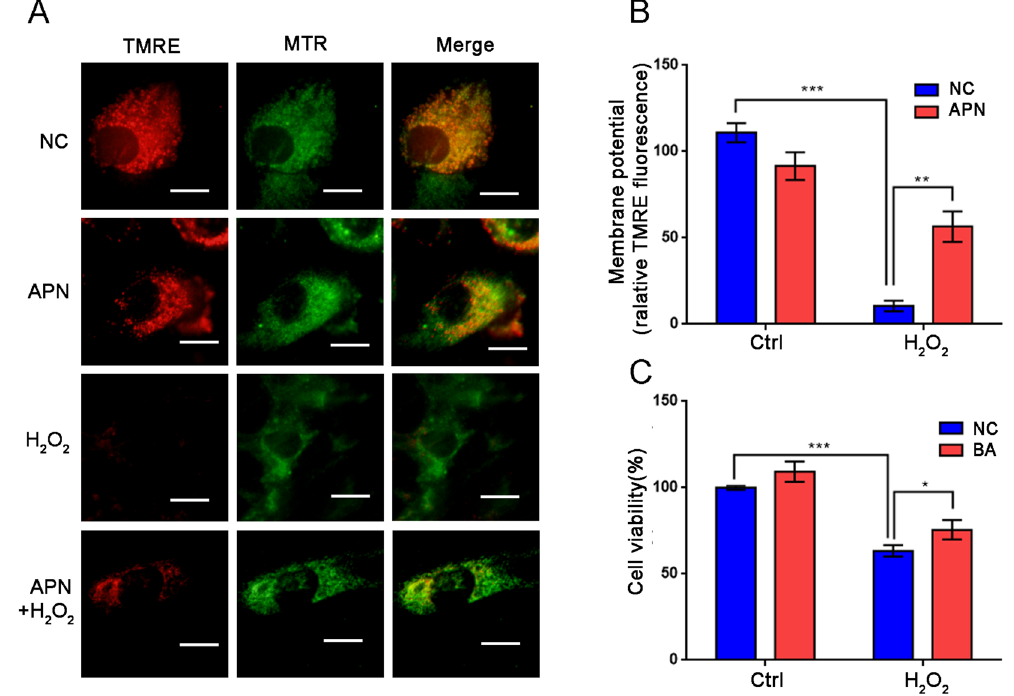
Figure 3. Effect of APN on H 2 O 2 -induced mitochondrial membrane potential. ( A ) C2C12 cells were transfected with 30 μ g/mL APN, and control cells were treated with 5 mM H 2 O 2 for 1 h. Representative fluorescence images of TMRE and MitoTracker Green FM (MTR) are shown. Scale bar, 5 μ m. ( B ) Quantification of TMRE signals in cells before and after H 2 O 2 treatment (mean ± SEM; n = 100 cells from 3 independent experiments, ** p < 0.01, *** p < 0.001). ( C ) Influence of BA on H 2 O 2 -induced cell viability. C2C12 cells were pretreated with 15 μ M BA for 1 h and then incubated with or without 5 mM H 2 O 2 for 1 h. Cell viability was evaluated using a Cell Counting Kit-8. The data are expressed as the percentage of mean values ± SEM of experiments performed in triplicate ( * p < 0.05, *** p <